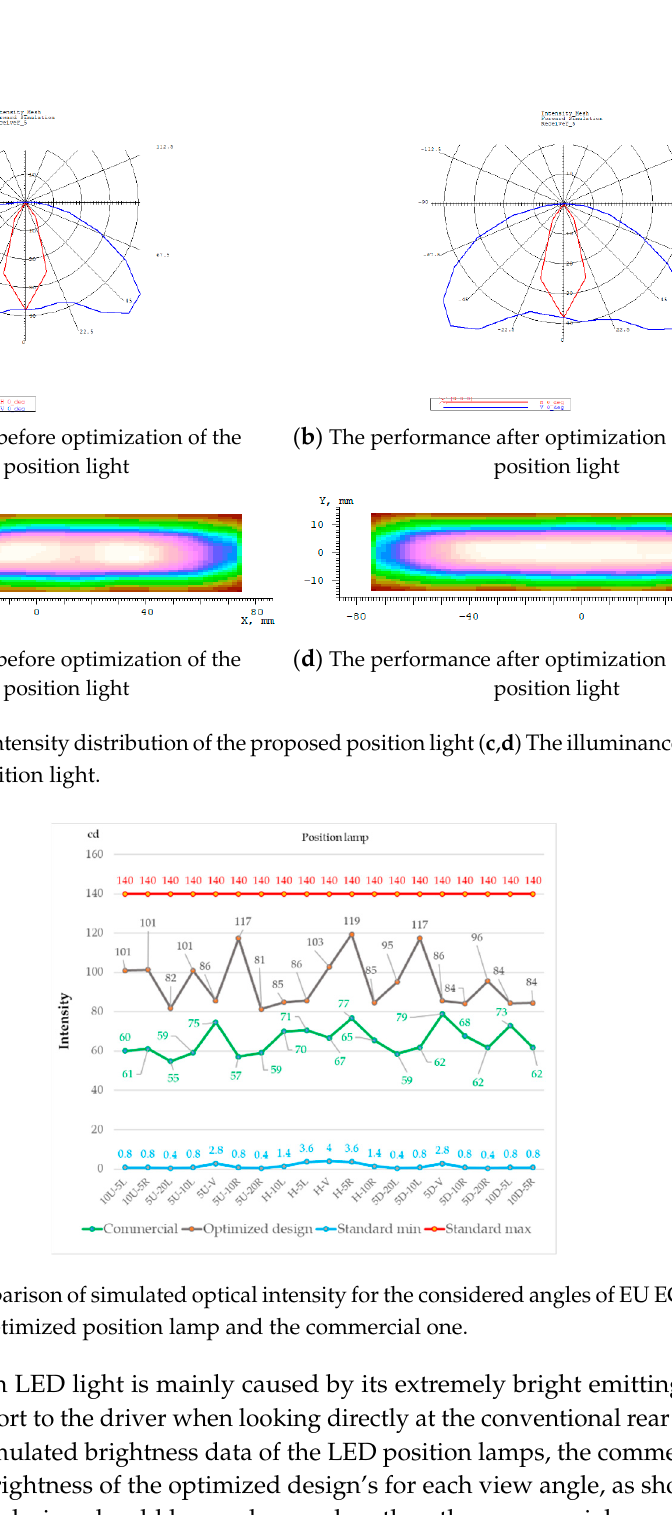
( b ) Figure 7. The flowchart of ( a ) the proposed rear light simulation; ( b ) the prism structure optimization.